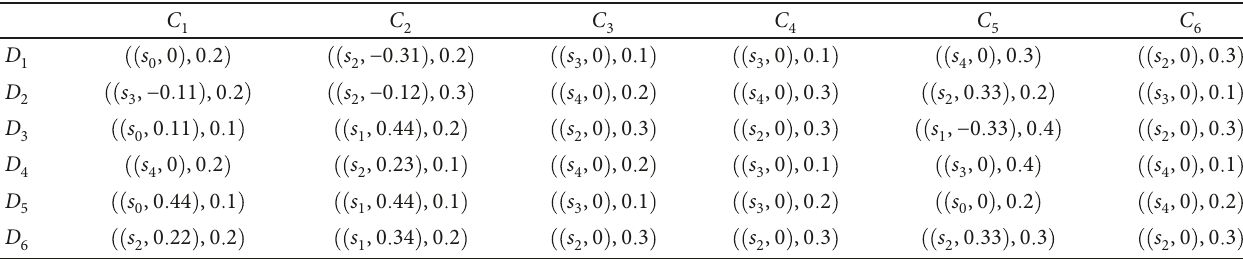
Table 1: Grey linguistic 2-tuple decision matrix Z 1 .